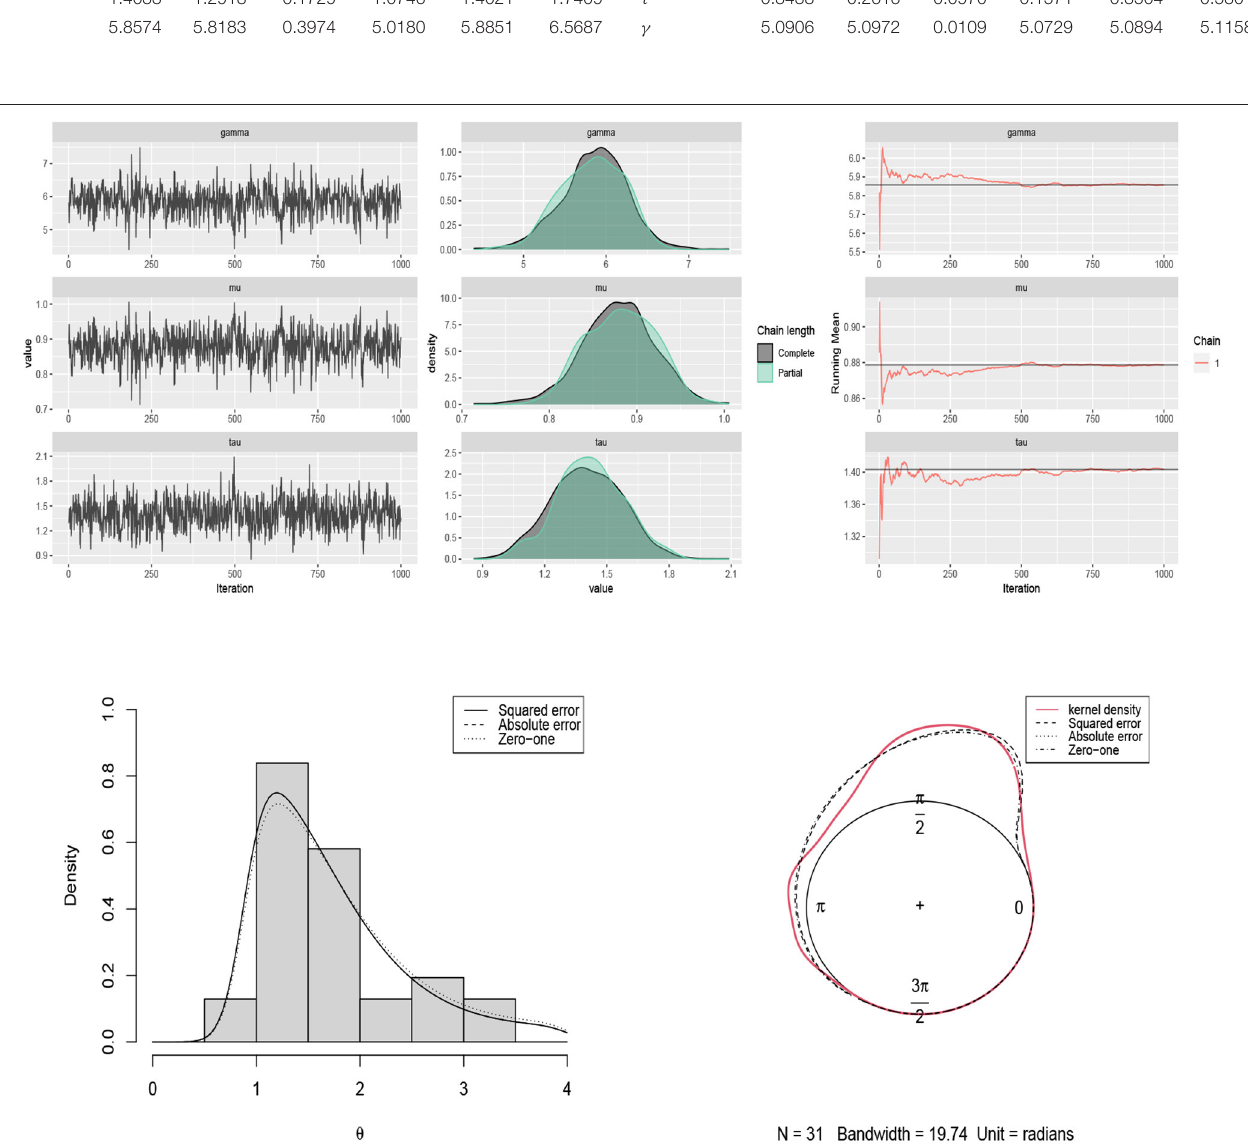
FIGURE 8 | (Top) traceplots, mean running and estimated posterior pdf plots of generated samples for ( µ , τ , γ ) in Table 2 for the movement of blue periwinkles dataset. (Bottom) the histogram and kernel density plot of the data related to the movement of blue periwinkles and the fitted curves under different loss functions.